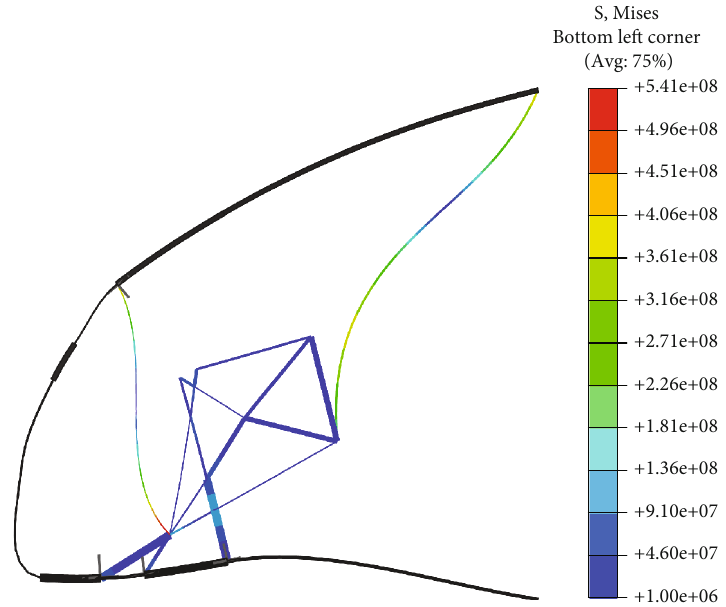
Figure 2: Topology solution for the internal